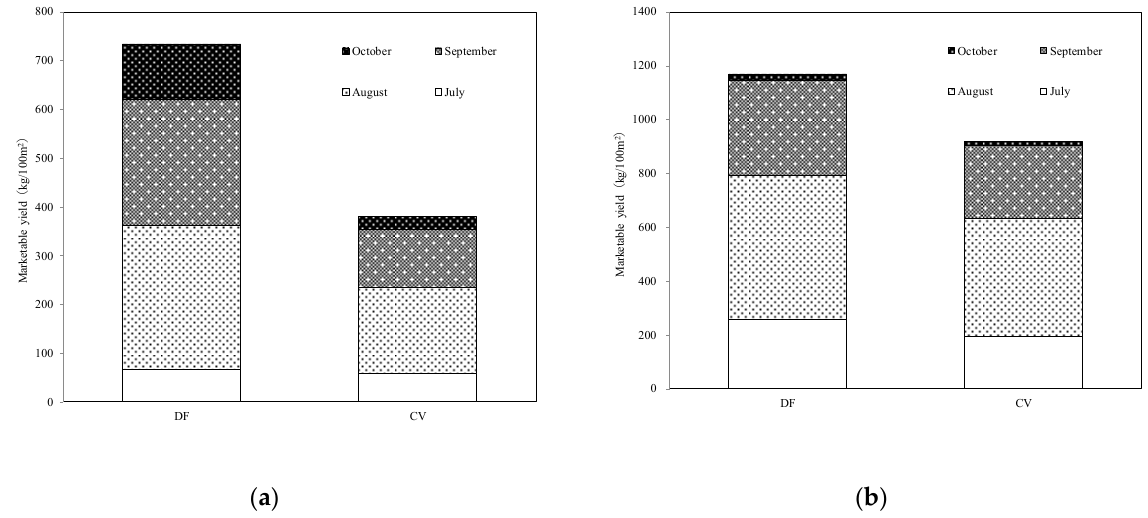
Figure 4. Effect of drip fertigation on cucumber yield. ( a ) 2016. ( b ) 2017. DF, drip fertigation; CV, conventional fertilization.